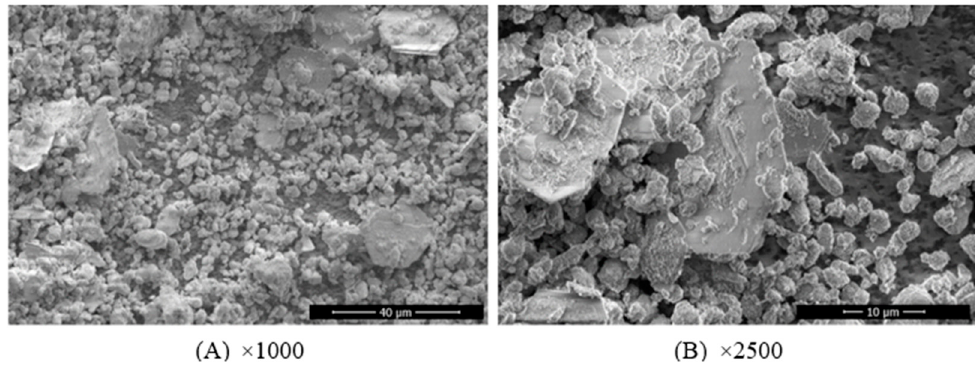
Figure 3. Microstructure of dry concrete sludge: ( A ) ×1000 magnification and ( B ) ×2500 magnification.